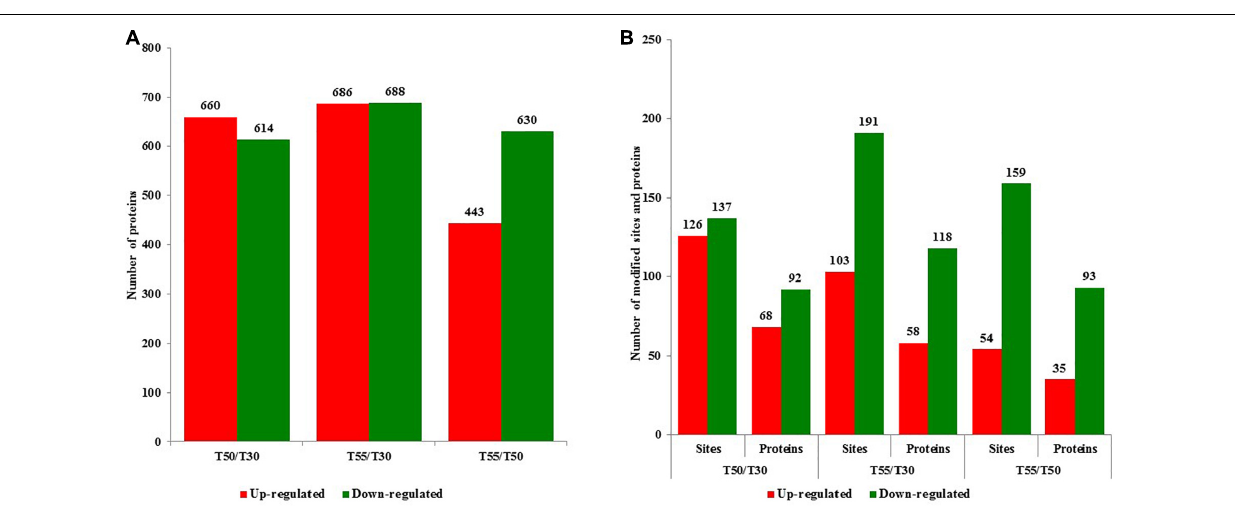
FIGURE 2 | The number of upregulated and downregulated proteins and N-glycoproteins with fold change over 1.5-fold. (A) The number of upregulated and downregulated proteins in T50/T30, T55/T30, and T55/T50, respectively. (B) The number of upregulated and downregulated N-glycoproteins in T50/T30, T55/T30, and T55/T50,